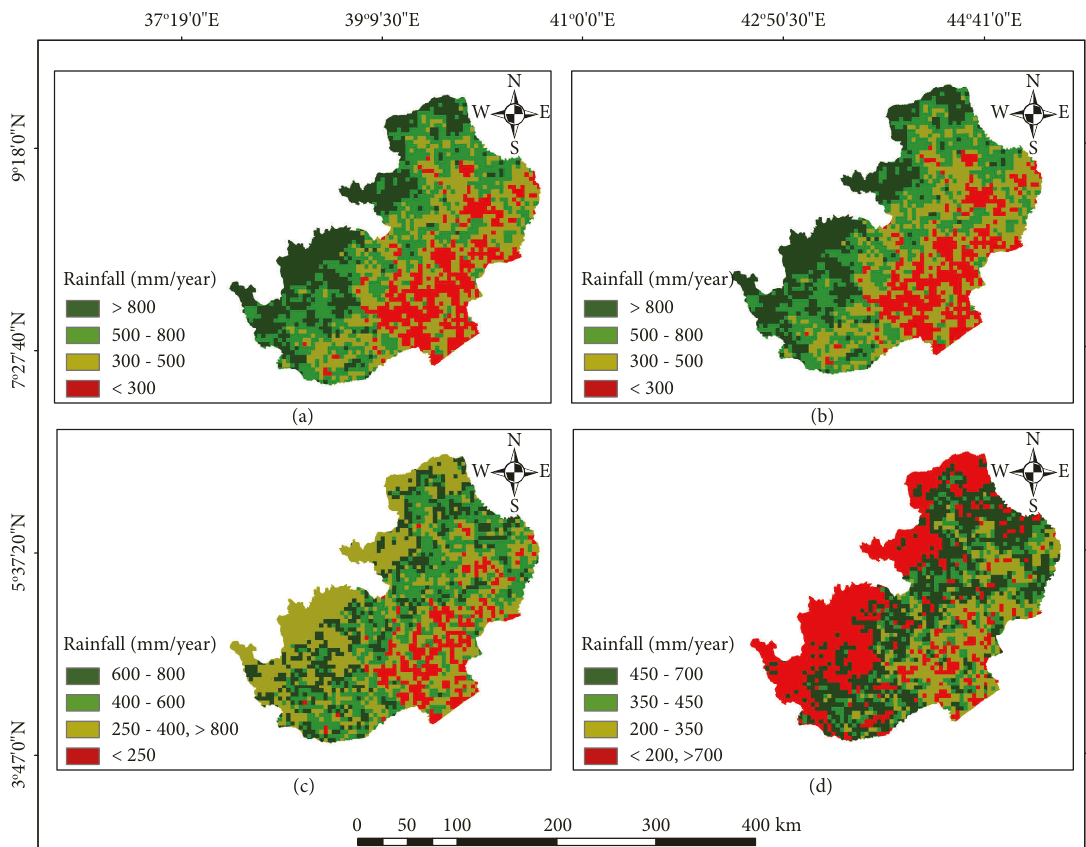
Figure 3: Rainfall factor map for livestock production: (a) cattle, (b) sheep, (c) goat, and (d)